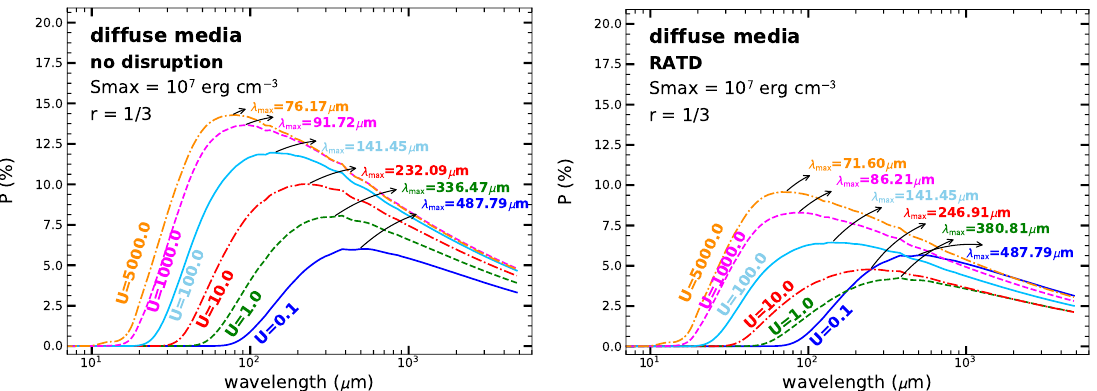
Figure 13. Polarization spectrum of thermal emission from aligned grains by RATs with axial ratio r = 1/3 in the diffuse medium with various radiation field strengths, assuming no grain disruption (left panel) and with disruption by RATD (right panel). The tensile strength S max = 10 7 ergcm − 3 is considered. From Lee et al.